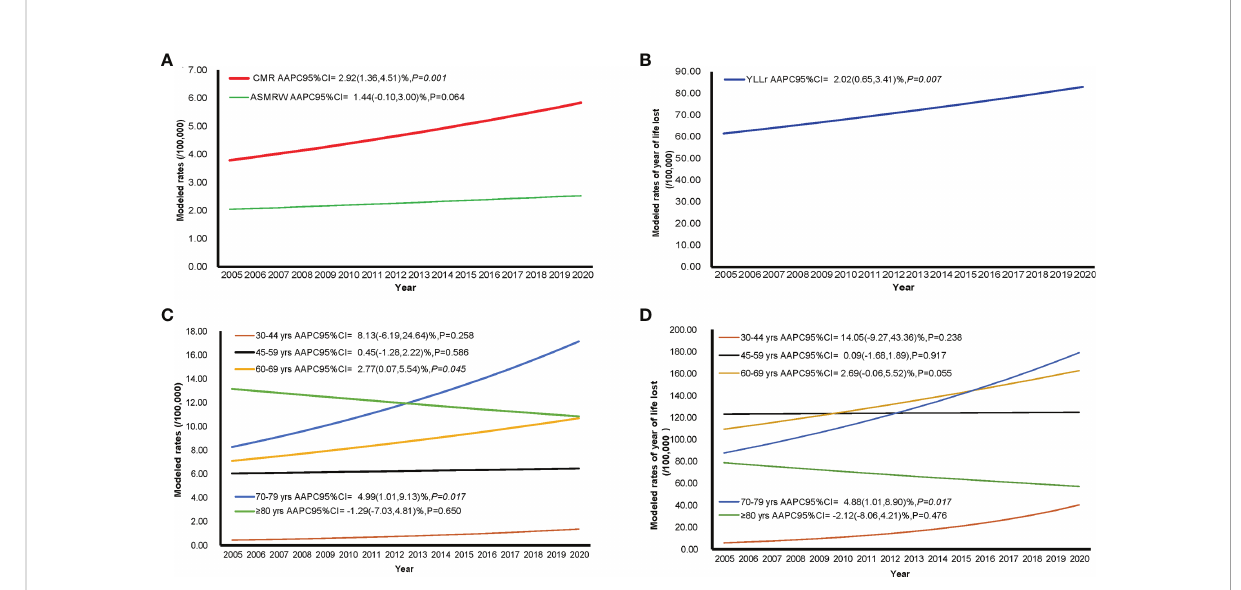
FIGURE 2 The trends in CMR, ASMRW, and YLL rate of persons with ovarian cancer death in Pudong New Area, Shanghai, China, 2005-2020. (A) trends in CMR and ASMRW; (B) trends in YLL rate; (C) trends in CMR among different age groups; (D) trends in YLL rate among different age groups. ASMRW, age-standardised mortality rate by Segi ’ s world standard population; CMR, crude mortality rate; YLL, years of life lost.